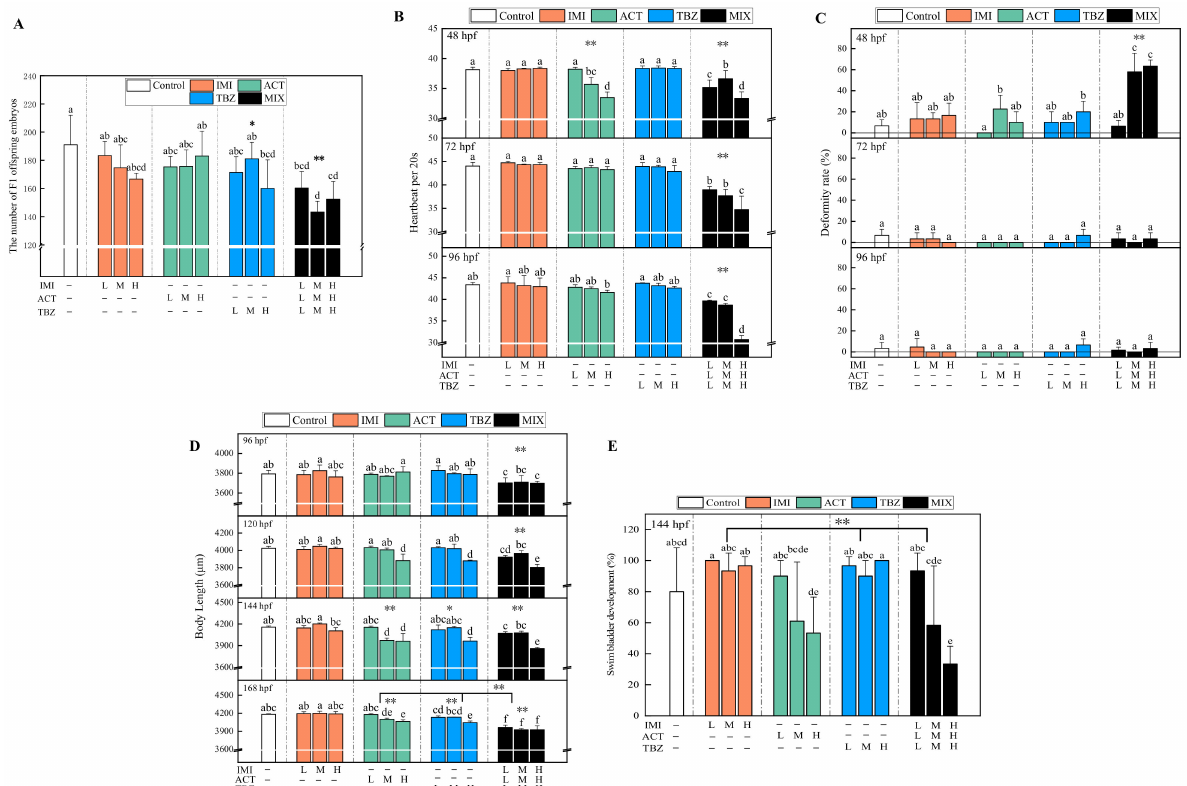
Figure 2. F1 offspring embryo indicators: ( A ) the number of F1 embryos; ( B ) the number of heart- beats per 20 s (48–96 hpf); ( C ) deformity rate (48–96 hpf); ( D ) body length (96–168 hpf); ( E ) swim bladder development (144 hpf). Here L: low concentration, M: medium concentration, and H: high concentration. In the figure, “a, b, c, . . . ” indicate that the results were analyzed by one-way ANOVA; “* and **” indicate the significant differences between the exposure groups and the control and the results were analyzed by two-way ANOVA (*: p < 0.05; **: p <